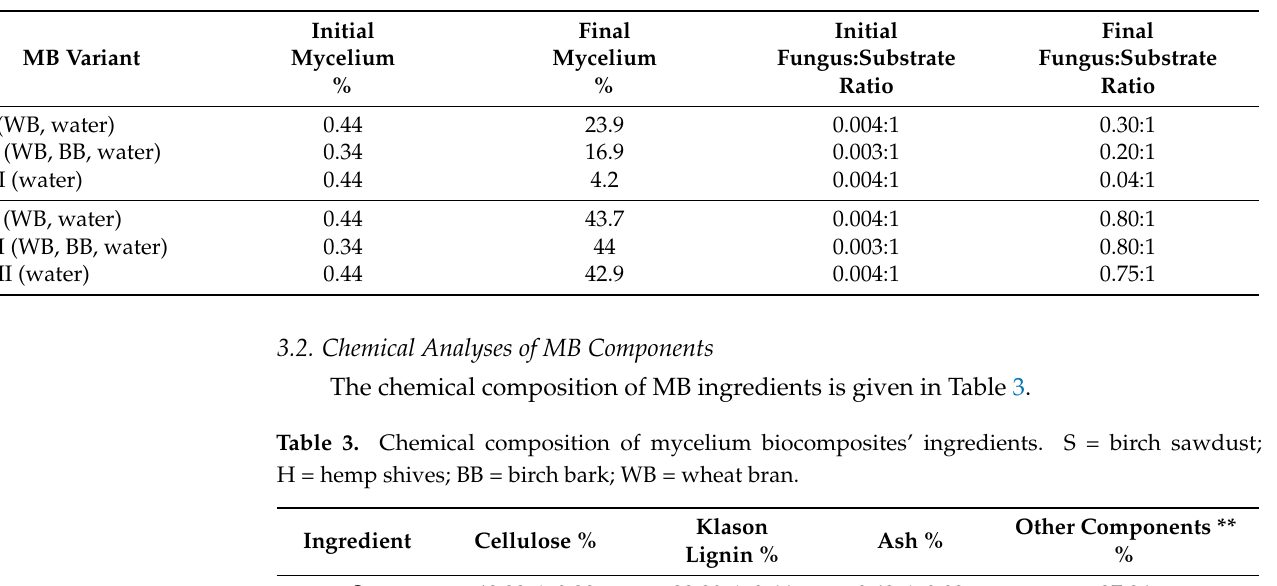
Table 2. Initial and final mycelium biomass by dry weight (%) in mycelium biocomposites (MB).